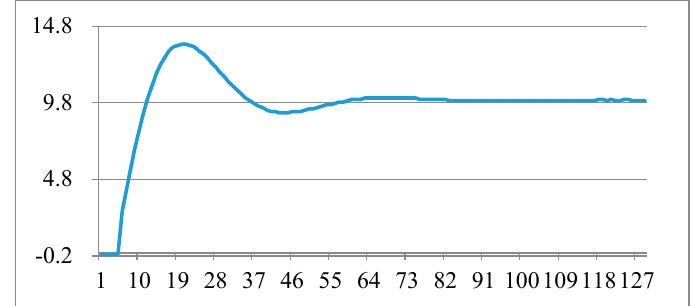
Figure 9. Phase-locked angle test when the angle suddenly changes by 10 degrees.